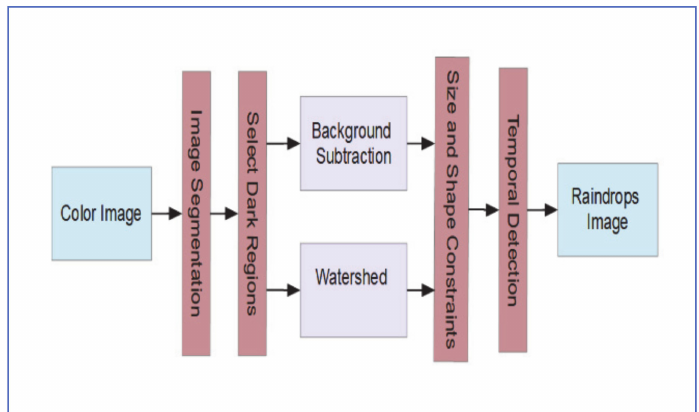
Figure 18. Raindrop detection algorithm described by Cord and Gimonet [38].